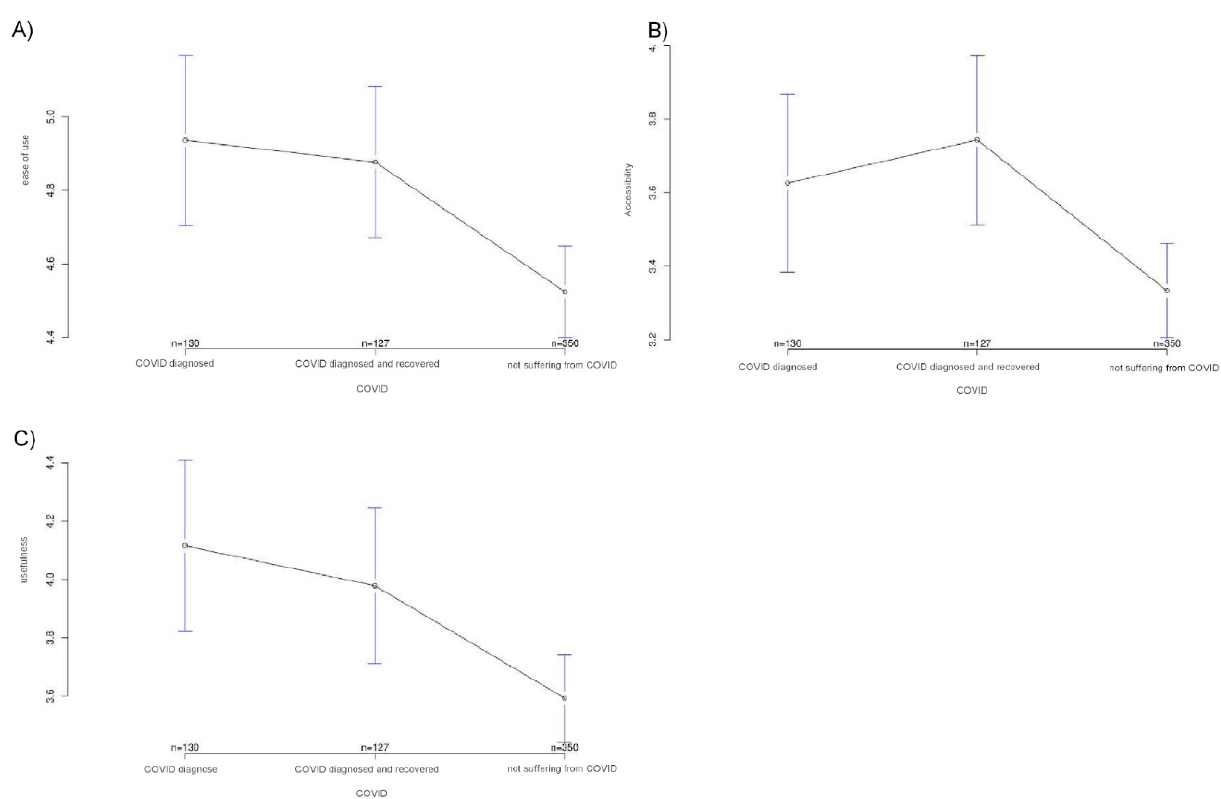
Figure 2. Expectation scores related to ease of use ( A ), accessibility ( B ), and usefulness ( C ) of the ECG patch in the three study groups. The y -axis shows the mean result of participants choice on the Likert scale.